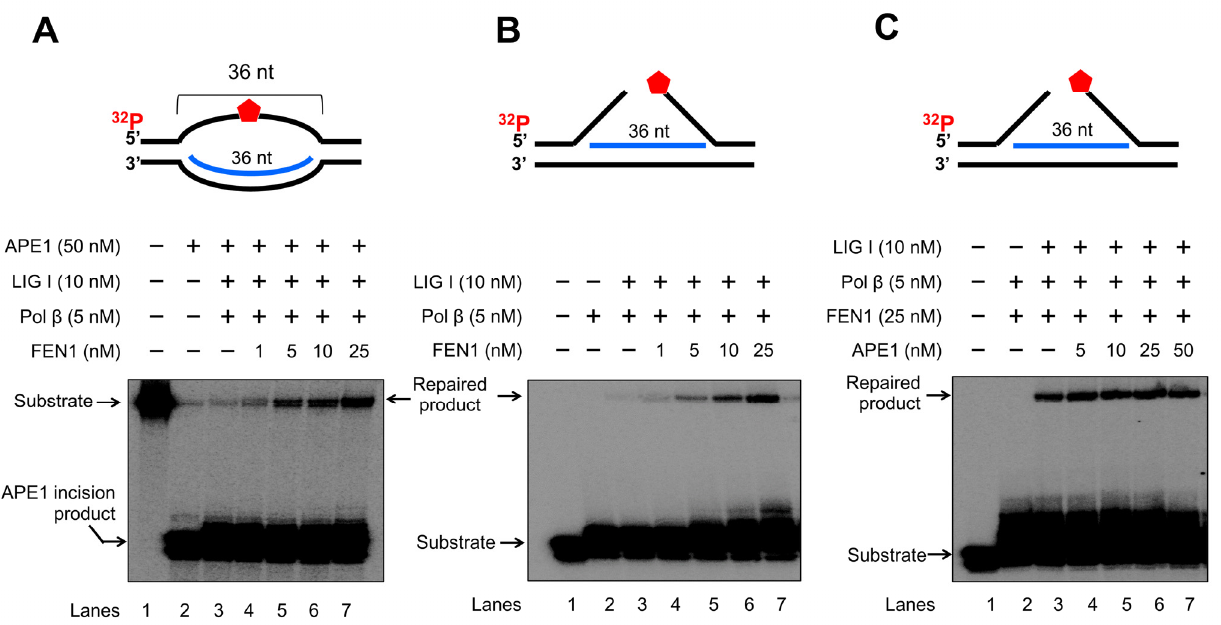
Figure 9. FEN1 and APE1 coordinate to promote the resolution of R-loops during BER. The co- ordination between FEN1 endonucleolytic cleavage activity and APE1 exonucleolytic activity in resolving R-loops through BER was determined by reconstituting BER with 25 nM R-loop substrates with an abasic site on the non-template strand and R-loop double-flap substrate. Enzymes and substrates were incubated at 37 ◦ C for 30 min. ( A ) BER was reconstituted with 25 nM R-loop substrate containing an abasic site on the non-template strand and different concentrations of FEN1 (1–25 nM) in the presence of 50 nM APE1, 5 nM pol β and 10 nM LIG I. Lane 1 represents substrate only. Lane 2 represents the results from APE1 cleavage on the R-loopsubstrate. Lane 3 illustrates the results of FEN1 flap cleavage on the R-loop substrate. Lanes 4–7 represent the results of reconstituted BER in the presence of increasing concentrations of FEN1. ( B ) BER was reconstituted with 25 nM R-loop double-flap substrate in the presence of 5 nM pol β and 10 nM LIG I. Lane 1 represents substrate only. Lane 2 indicates the reaction mixture with pol β and the substrate. Lane 3 illustrates the reaction mixture with pol β and LIGI and the substrate. Lanes 4–7 represent the reaction mixture with increasing concentrations of FEN1. ( C ) BER was reconstituted with the R-loop double-flap substrate with increasing concentrations of APE1 in the presence of 5 nM pol β , 25 nM FEN1, and 10 nM LIG I. Lane 1 represents substrate only. Lane 2 illustrates the reaction mixture with pol β and FEN1. Lane 3 indicates the reaction mixture with FEN1, pol β , and LIG I. Lanes 4–7 represent the reaction mixture with increasing concentrations of APE1 in the presence of pol β , FEN1 and LIG I. Substrates and products were separated in a 15% urea-denaturing polyacrylamide gel and detected by phosphorimagery. The experiments were performed in